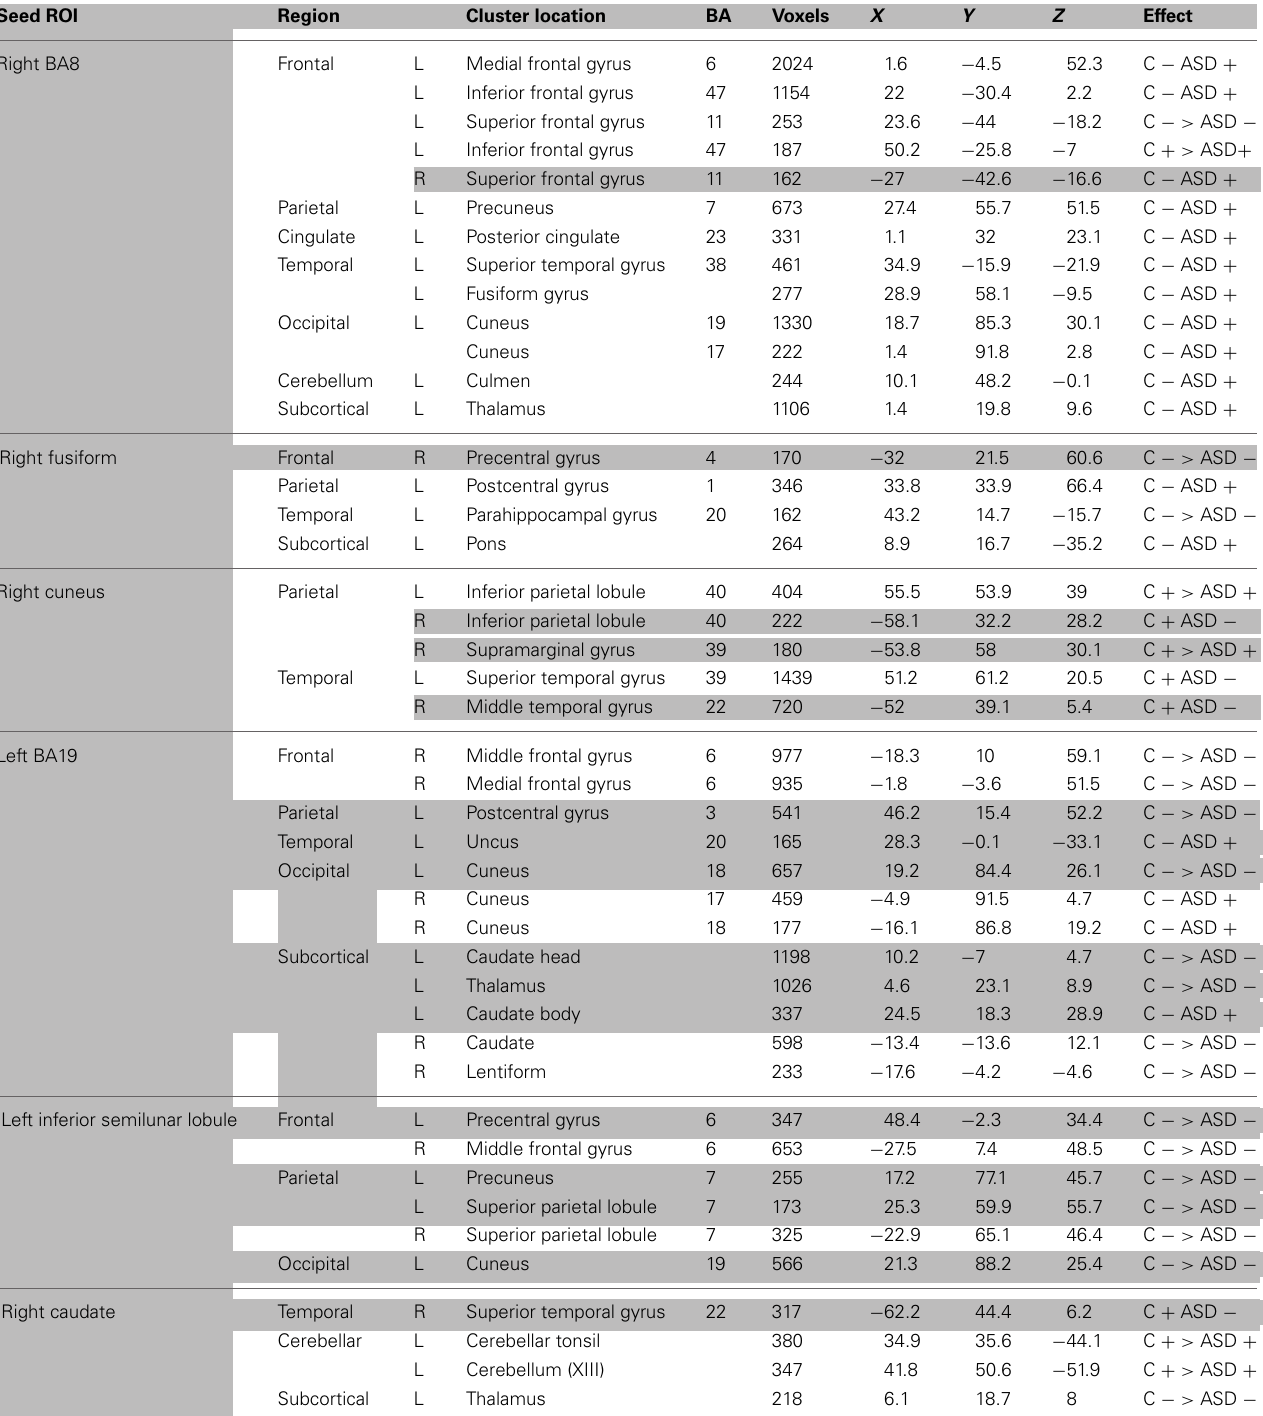
Table 2 | A modified version of Table 3 in McGrath et al. (2012), in which the results of between-group differences in functional connectivity are